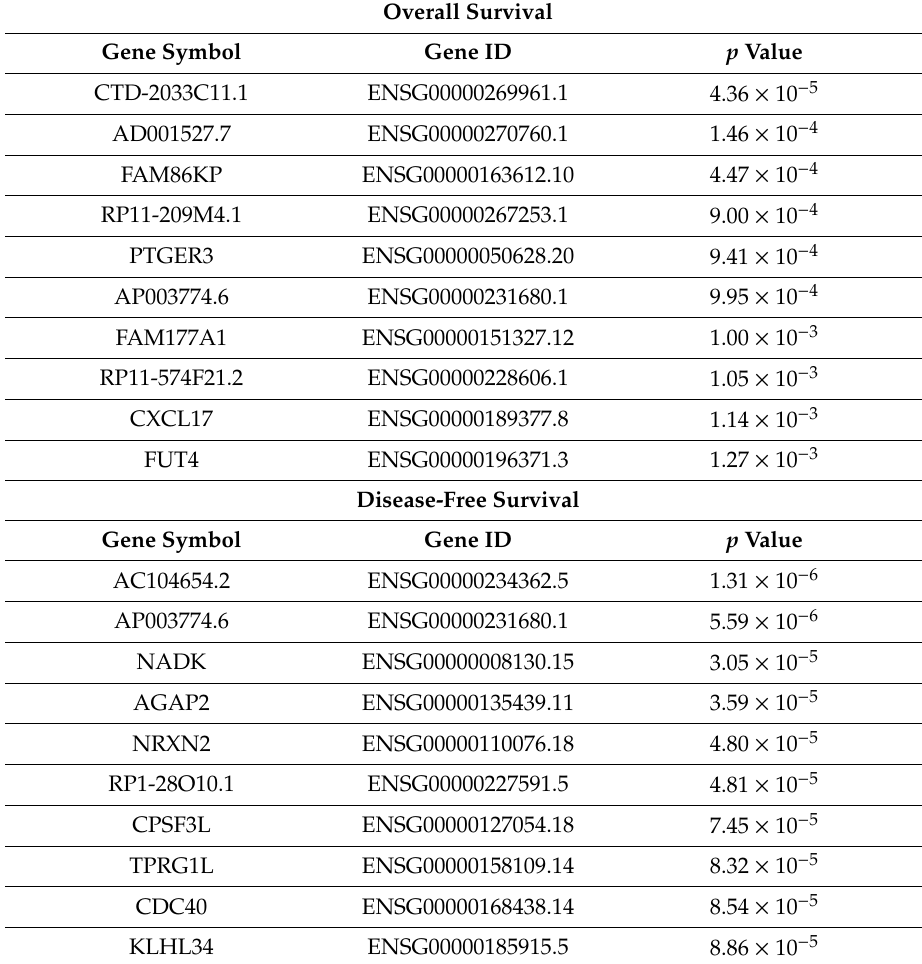
Table 4. Most significant survival genes in CCA. All candidates from gene expression profiling interactive analysis (GEPIA) website. Log-rank test (Mantel-Cox test), group cuto ff :